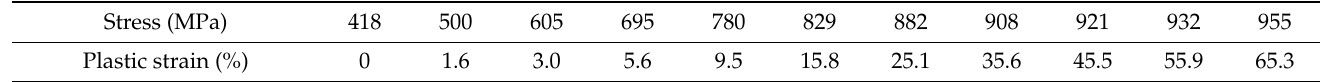
Table 1. The stress–strain correspondence of plastic deformation.